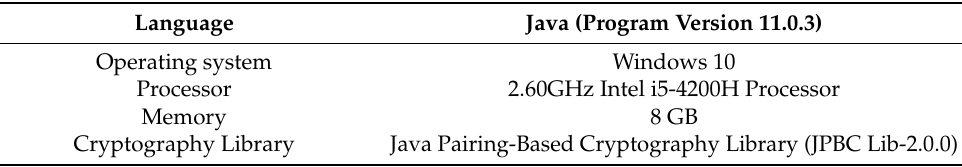
Figure 2. The comparison of verification time of our scheme and [18]. Table 2. Experimental